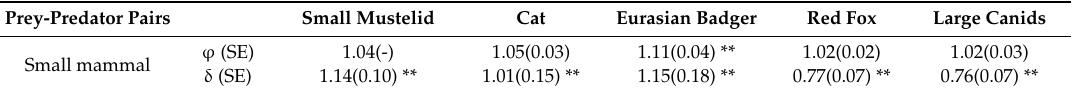
Table 2. Parameters of interspecific interactions between small mammals and predators representing the deviation from randomness of the probability of species co-occurrence in a crossing structure ( ϕ ) or on a given day ( δ ). Standard errors are given in parentheses, except where not computed due to a lack of variability at some passage types. * p < 0.05 and ** p < 0.01.